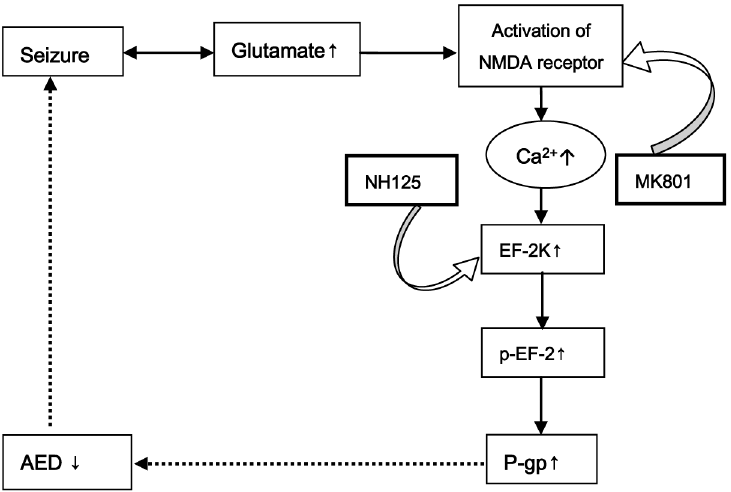
Fig 1. Schematic of proposed glutamate-NMDA receptor-P-gp signaling pathways and possible intervention sites.